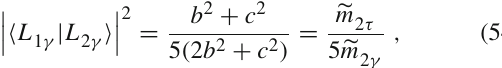
togenesis to be viable: the NO case with η η = 1 ( b ); the NO case with η 2